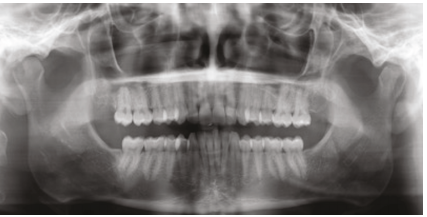
Figure 4: Panoramic radiography (one year